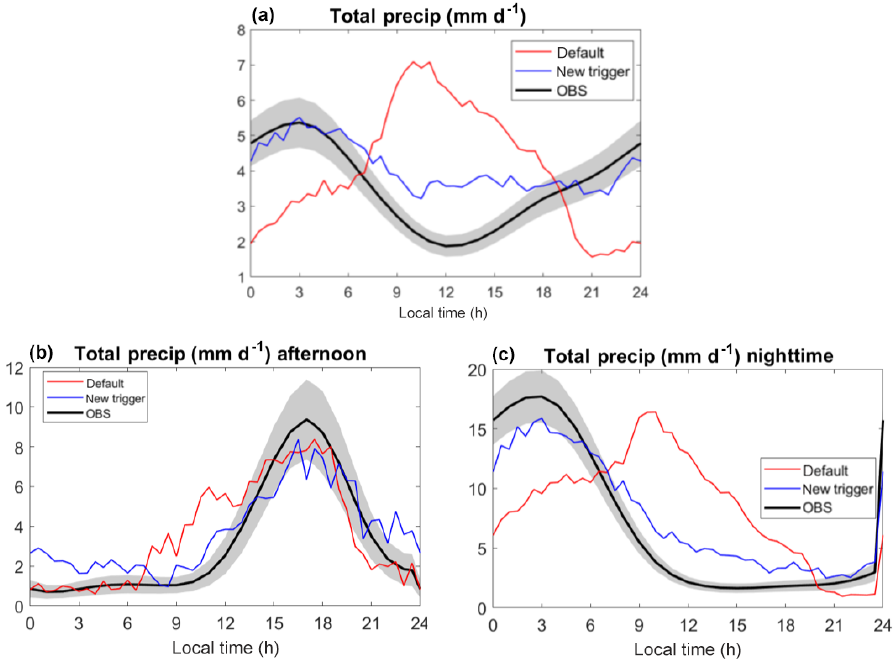
Figure 1. Composite of the total precipitation (convective + large scale) in local time for the E3SM SCM (red curve), E3SM SCM with the convective modifications documented in Xie et al. (2019; blue curve), and observations (black curve) from the Southern Great Plains (SGP) ARM site version 2. Panel (a) depicts all time samples from 1 May through 31 August from 2004 to 2015. Panel (b) represents periods when the observed precipitation has a peak greater than 1mmd − 1 between 13:00 and 20:00LST and when the peak rain rate is 1.5 times greater than any rain rate outside of 13:00 to 20:00LST. Panel (c) represents periods when the observed precipitation is greater than 1mmd − 1 with a peak time between 00:00 and